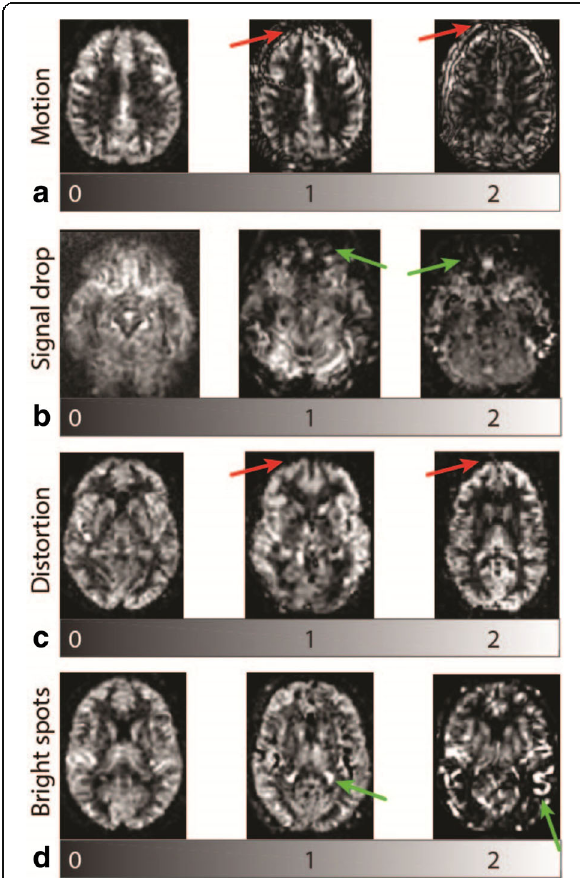
Fig. 2 Cerebral blood flow images containing examples of artifacts: a motion artifacts are observed as pseudo-perfusion hyperintensity rings (red arrows), b signal drop in the inferior orbitofrontal region (green arrows), c geometric anterior-posterior distortion (red arrows), d bright spots depicting macro-vascular artifacts from the posterior cerebral artery behind the thalamus (1) and in the cortex (2, green arrows). Note that the 0 signal drop image is a 3D spiral image, for a better contrast on how the inferior orbitofrontal perfusion should appear without signal